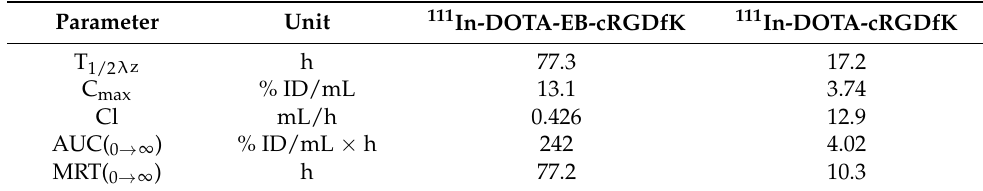
Table 3. Pharmacokinetic parameter estimates of 111 In-DOTA-EB-cRGDfK and 111 In-DOTA-cRGDfK after intravenous administration in U-87 MG tumor-bearing